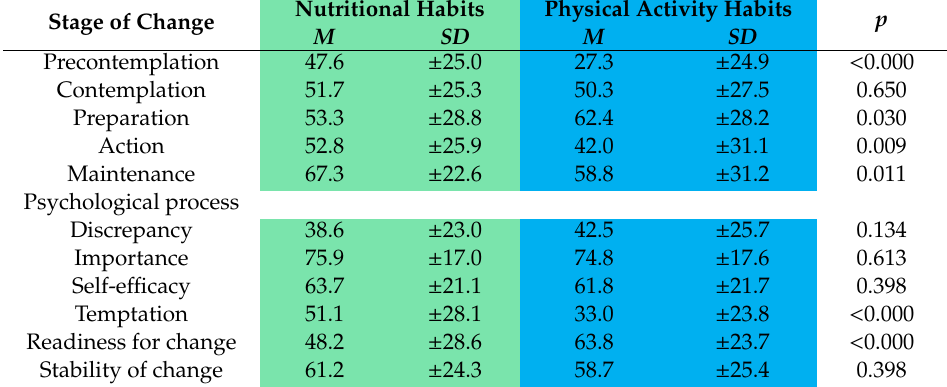
Table 2. Mean ( M ) scores and standard deviation ( SD ) of stages of change and of psychological processes for nutritional and physical activity habits.